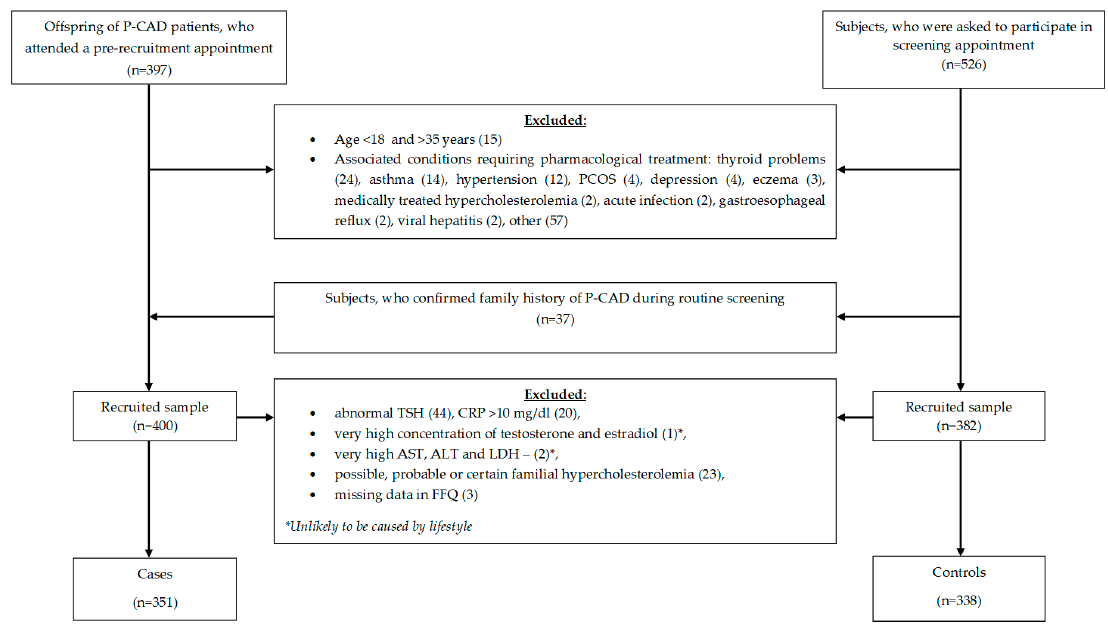
Figure 1. Recruitment flow-chart.